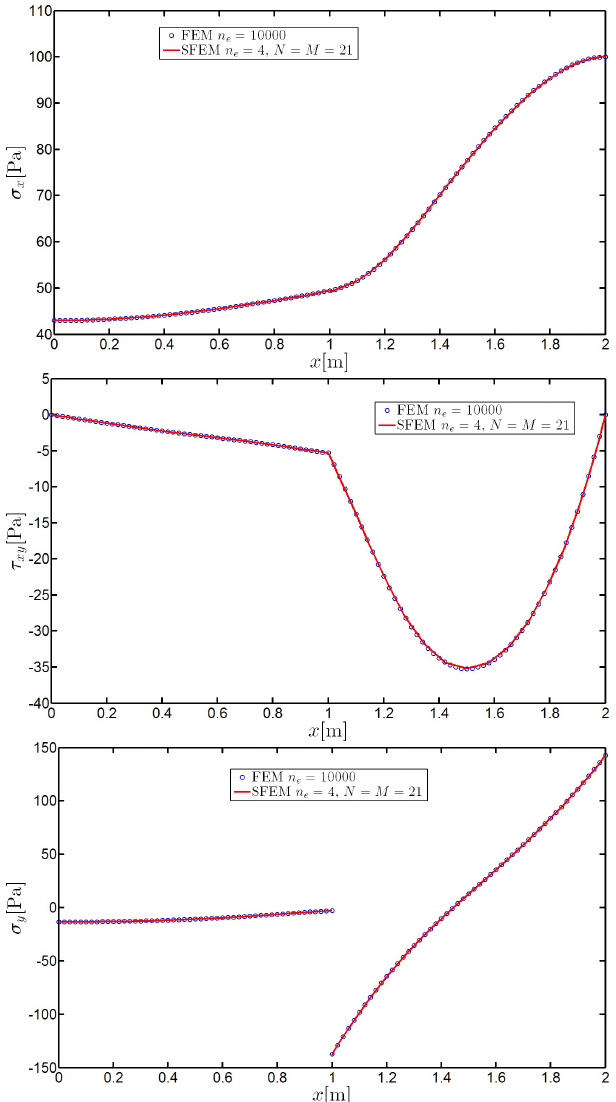
Figure 14: The present result using N = M = 21 for each element is compared to the same computed by